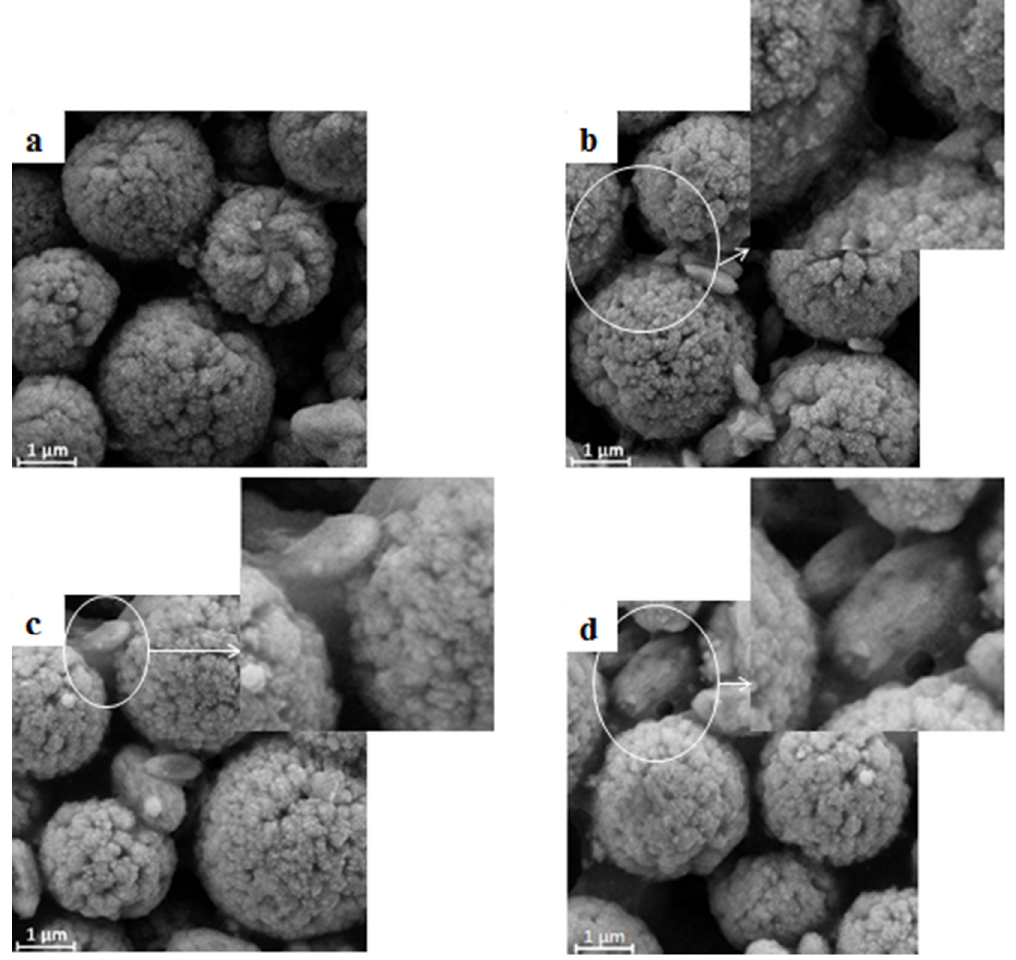
Figure 3. SEM micrographs of bifunctional BaSO 4 sheets with different mass ratio of cellulose acetate (CA) to BaSO 4 : ( a ) 0.02:1; ( b ) 0.03:1; ( c ) 0.04:1; ( d ) 0.05:1.